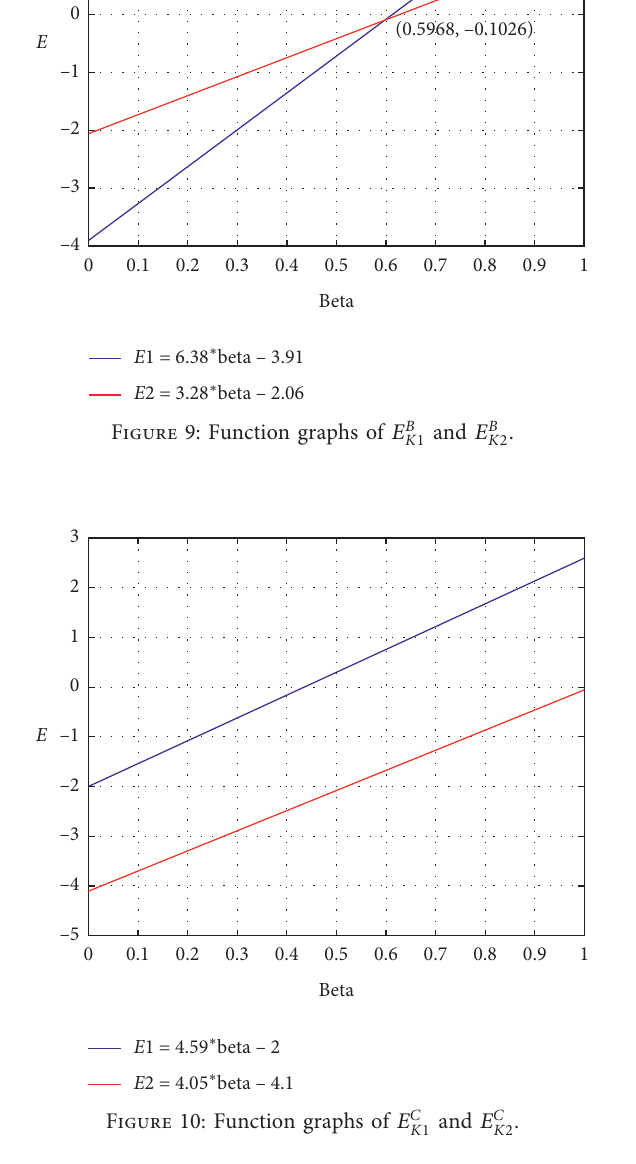
E C K 1 and K 2 .